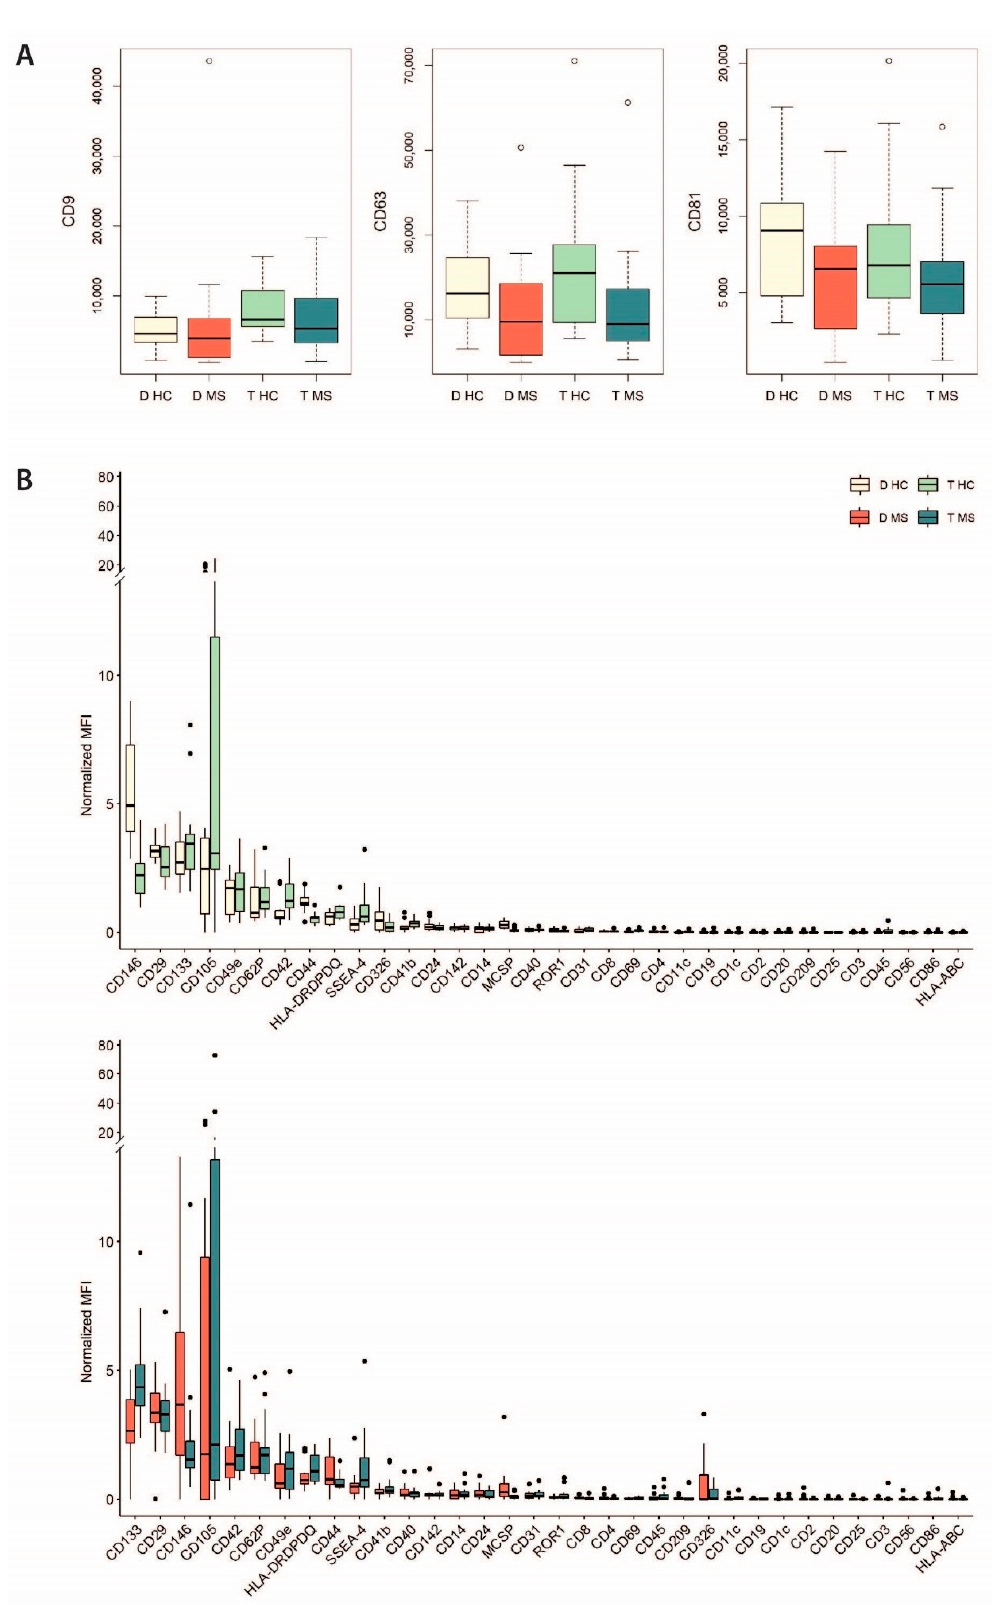
Figure 2. Characterization of surface markers of placental EVs by multiplex bead-based flow cytometry assay. ( A ) Median fluoresce intensity (MFI) of the exosomal tetraspanins CD9, CD63, and CD81. ( B ) MFI of the other markers relative to the mean value of tetraspanins’